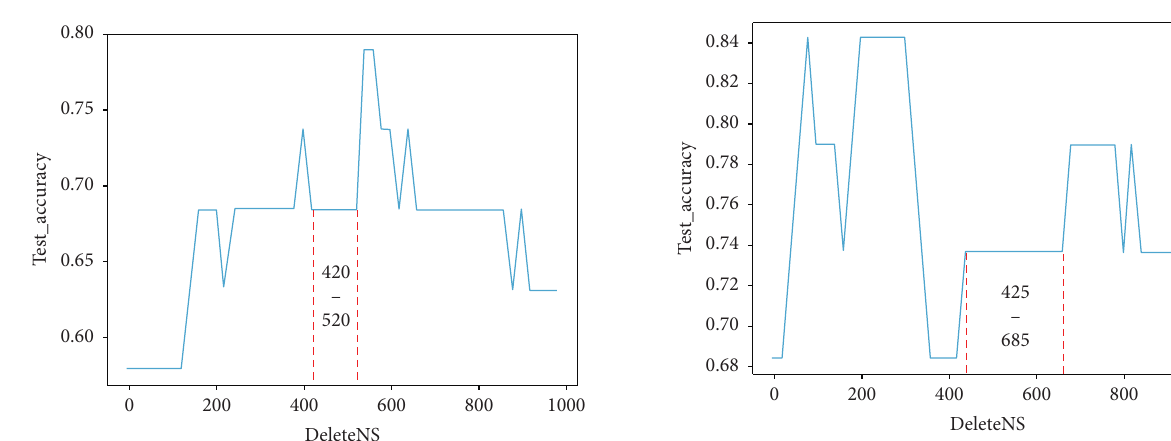
Figure 1: Curve 1 of deleteNS and classification accuracy.